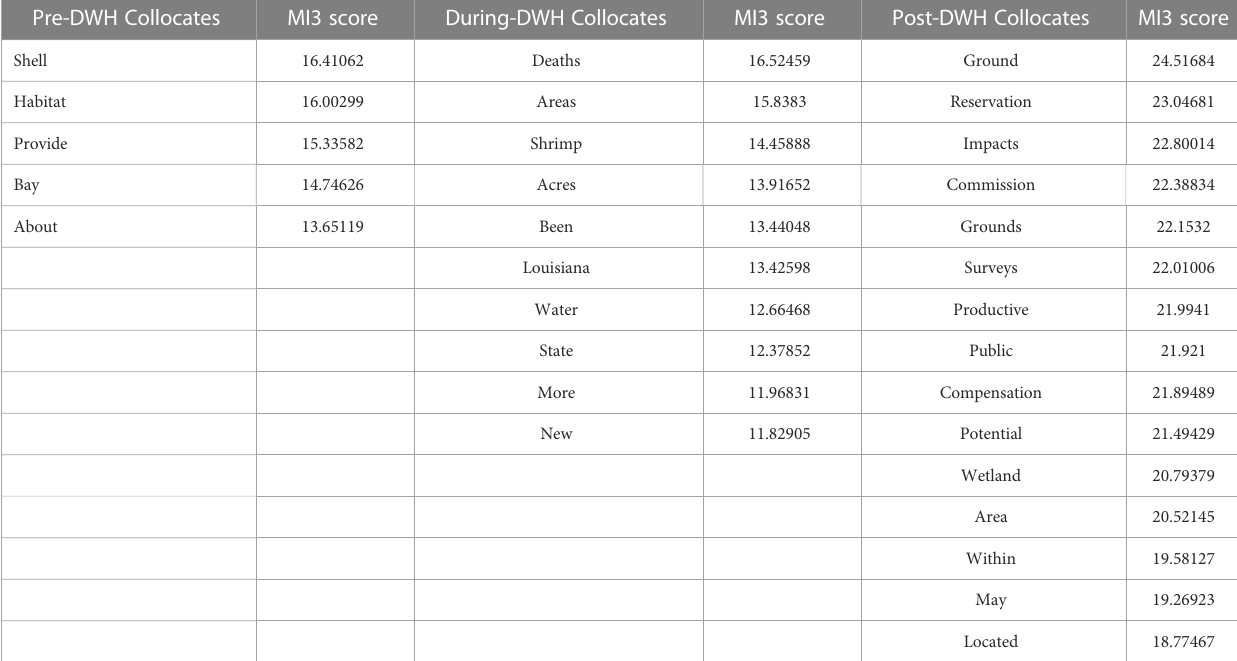
TABLE 4 Salient collocates for each time span with MI3